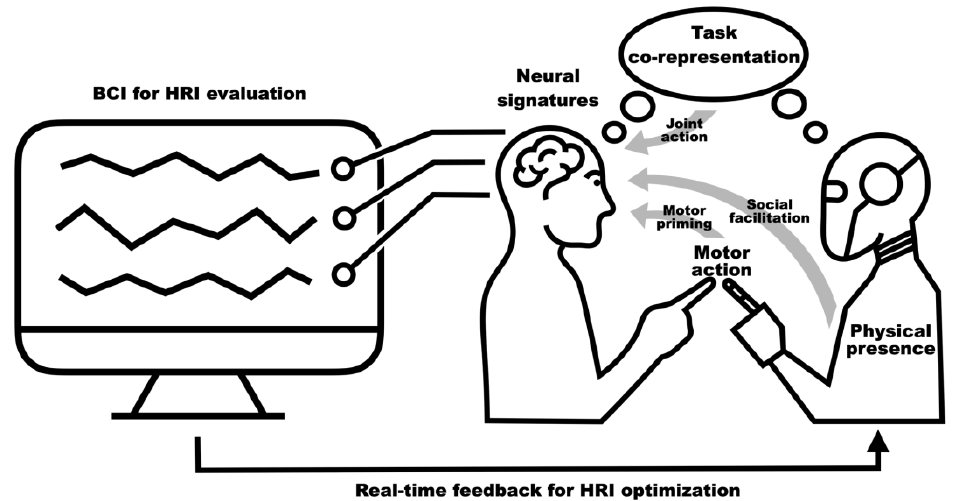
Figure 1. Potential psychological effects of a robotic agent on an interacting human partner in human-robot interaction (HRI) with brain-computer interface (BCI)-based real-time evaluation and optimization.